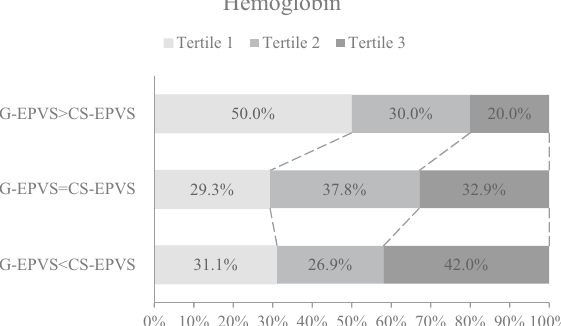
Figure 5. Distribution of the tertiles (tertile 1–tertile 3) of hemoglobin in patients grouped by 3 EPVS predominance patterns. The percentage of each tertile is shown in each cell. The proportion of hemoglobin tertiles (tertile 1–tertile 3) in patterns from BG-EPVS predominance to CS-EPVS predominance showed significant difference (P = 0.004), and the proportion of Tertile 3 from BG-EPVS predominance pattern to CS-EPVS predominance pattern increased significantly (P = 0.012). BG basal ganglia, CS centrum semiovale, EPVS enlarged perivascular